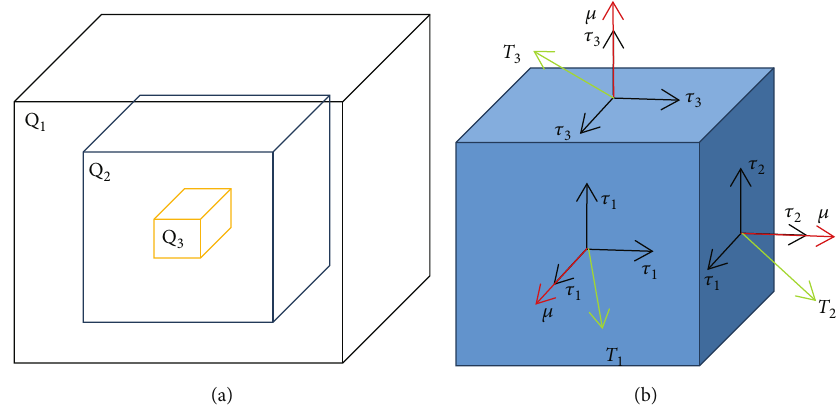
Figure 5: Mechanical model of roadway surrounding rock. (a) Schematic diagram of roadway surrounding rock. (b) The stress state of any point of surrounding